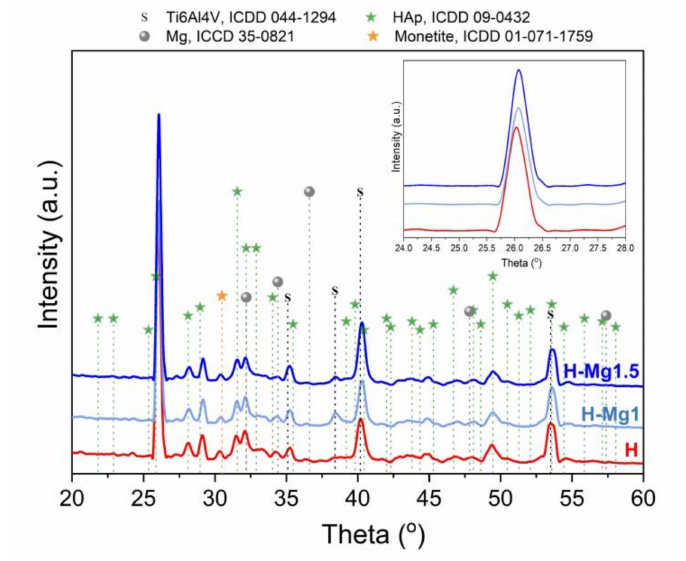
Figure 5. The X-ray di ff ractograms for undoped and Mg-doped